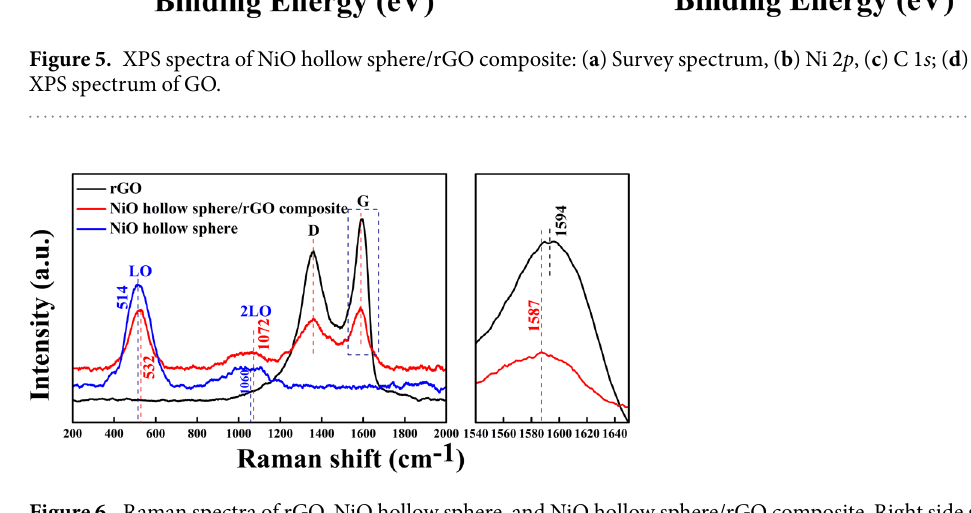
Figure 6. Raman spectra of rGO, NiO hollow sphere, and NiO hollow sphere/rGO composite. Right side shows the enlarged G band of rGO and NiO hollow sphere/rGO composite marked by a rectangle in